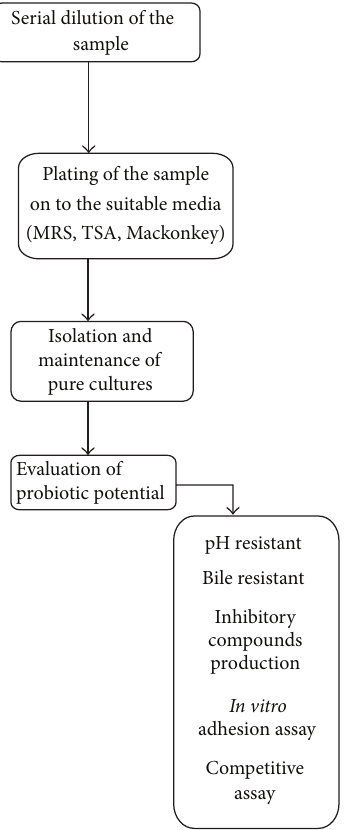
Figure 2: Microbiological procedure for evaluation of probiotic potential of microbial